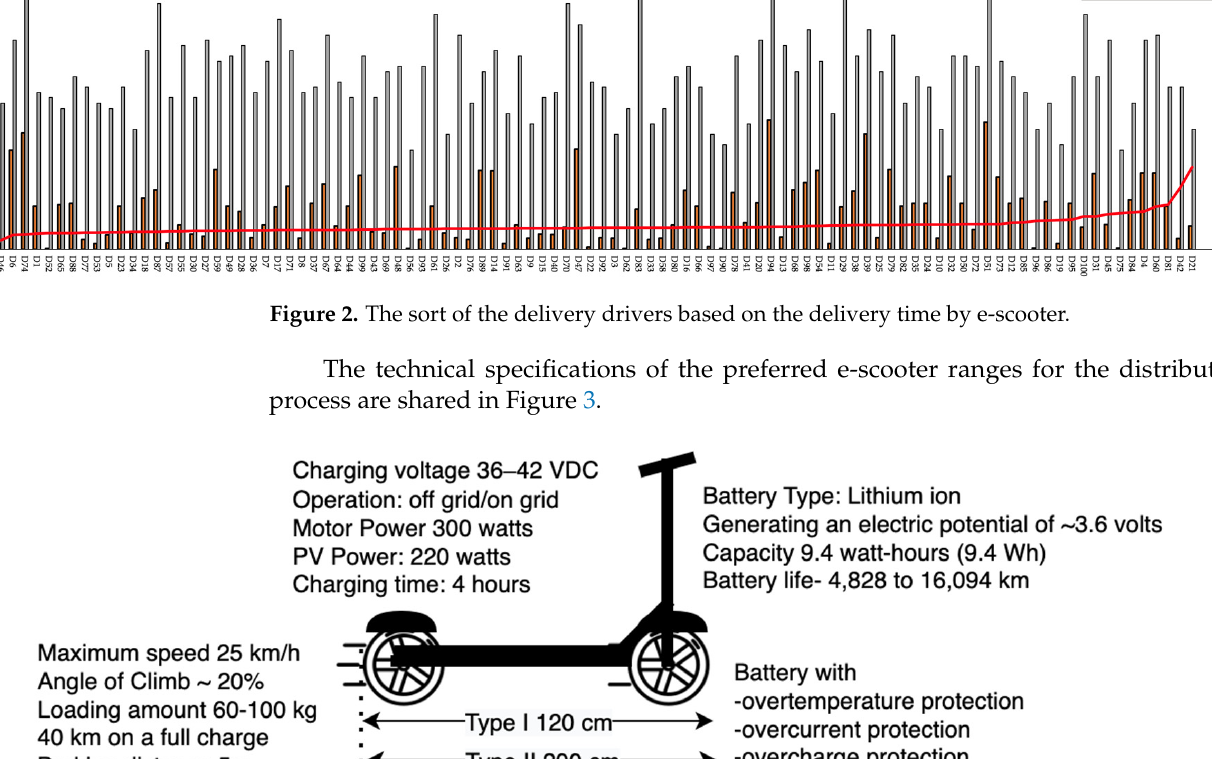
Figure 3. Technical specifications of the e-scooter.